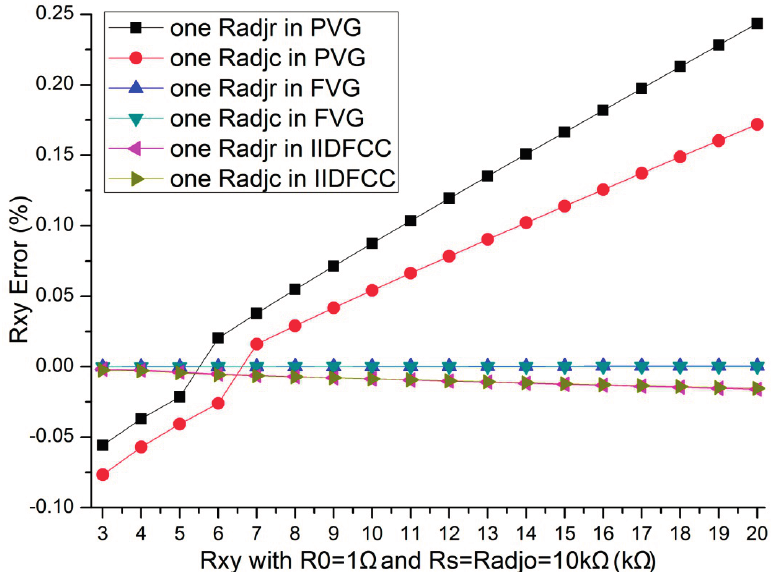
Figure 6. The R R = 10 k Ω adjo